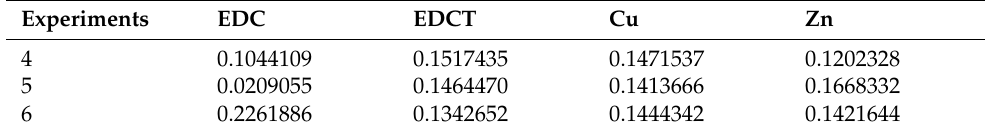
Table 12. Weighted normalized decision